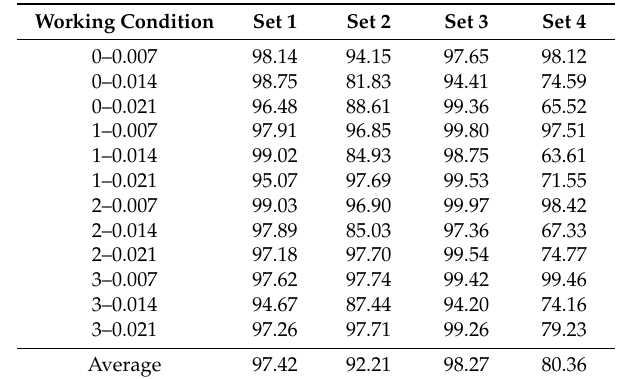
Table 3. Average diagnostic accuracy of all independent experiments corresponding to 12 different working conditions respectively in 1st–4th experiment sets.